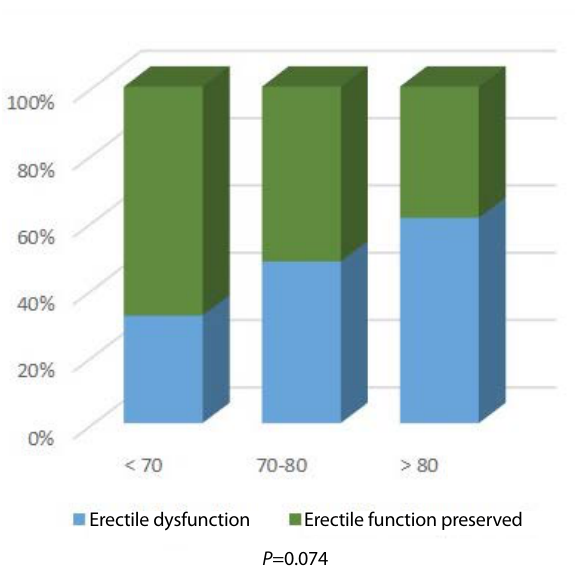
=0.074Erectile dysfunction Erectile function P Fig. 1 – Pre-EVAR erectile dysfunction by age group; P=0.074.